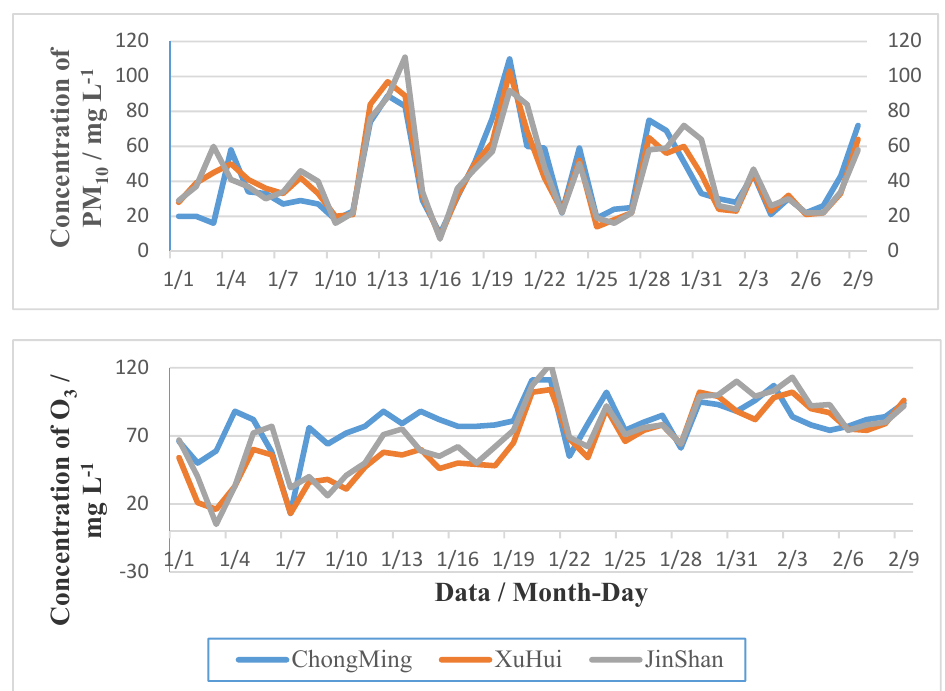
Figure 2. Changes in major pollutants from 1 January to 9 February with lockdown beginning on 23 January in different parts of Shanghai.